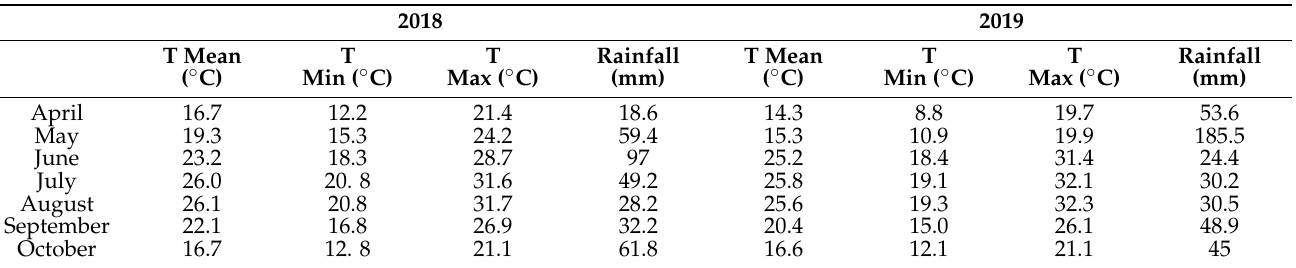
Table 1. Mean, minimum and maximum temperatures and rainfalls recorded throughout the 2018 and 2019 growing season